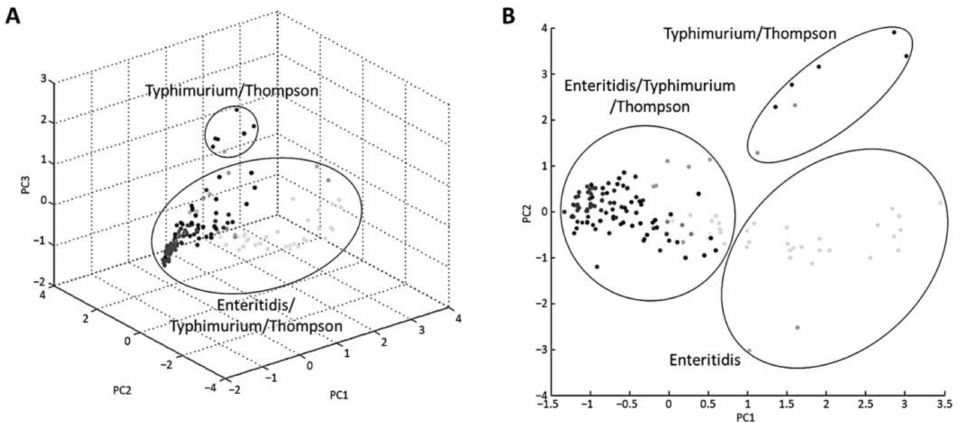
Figure 2. Principal component analysis (PCA) generated by mass spectra of 12 reference strains and 132 isolates. Each dot on the ( A ) three-dimensional plot and ( B ) two-dimensional plot represents strains.